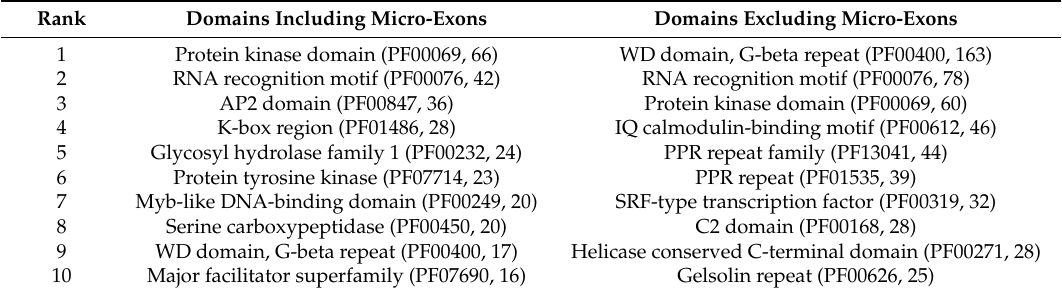
Figure 3. The proportion of conservation for micro-exons and domains in gene pairs. ( A ) The percentage of consistent domains between the conserved and non-conserved micro-exons. ( B – E ) Several examples of consistent and inconsistent domains with conserved and non-conserved micro-exons in ZS97 and MH63. Table 2. The top10 domains including and excluding micro-exons.